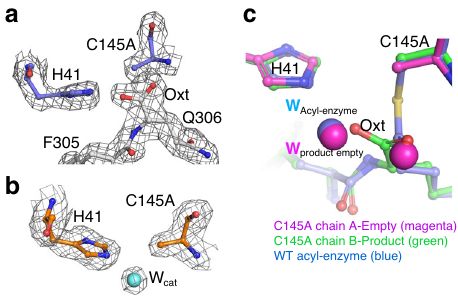
Fig. 3 C145A SARS-CoV-2 M pro product complex at 2.0 Å resolution. a 2mF o -DF c electron density (contoured at 1.0 σ ) in chain B of the C145A mutant shows presence of the bound C-terminal product of symmetry- related molecule B ′ . Also see Supplementary Fig. 5b. b 2mF o -DF c electron density (1.0 σ ) of empty protomer, chain A, of the same C145A mutant structure shows presence of a highly ordered water molecule hydrogen bonded to N ε 2 of His41, consistent with a general base role of the latter and coincident in position with the W cat weakly observed in the acyl-enzyme complex as in c and Fig. 1c. c Superposition of the product chain A (empty binding site; magenta) and chain B (product bound; green) with the acyl- enzyme (chain B;